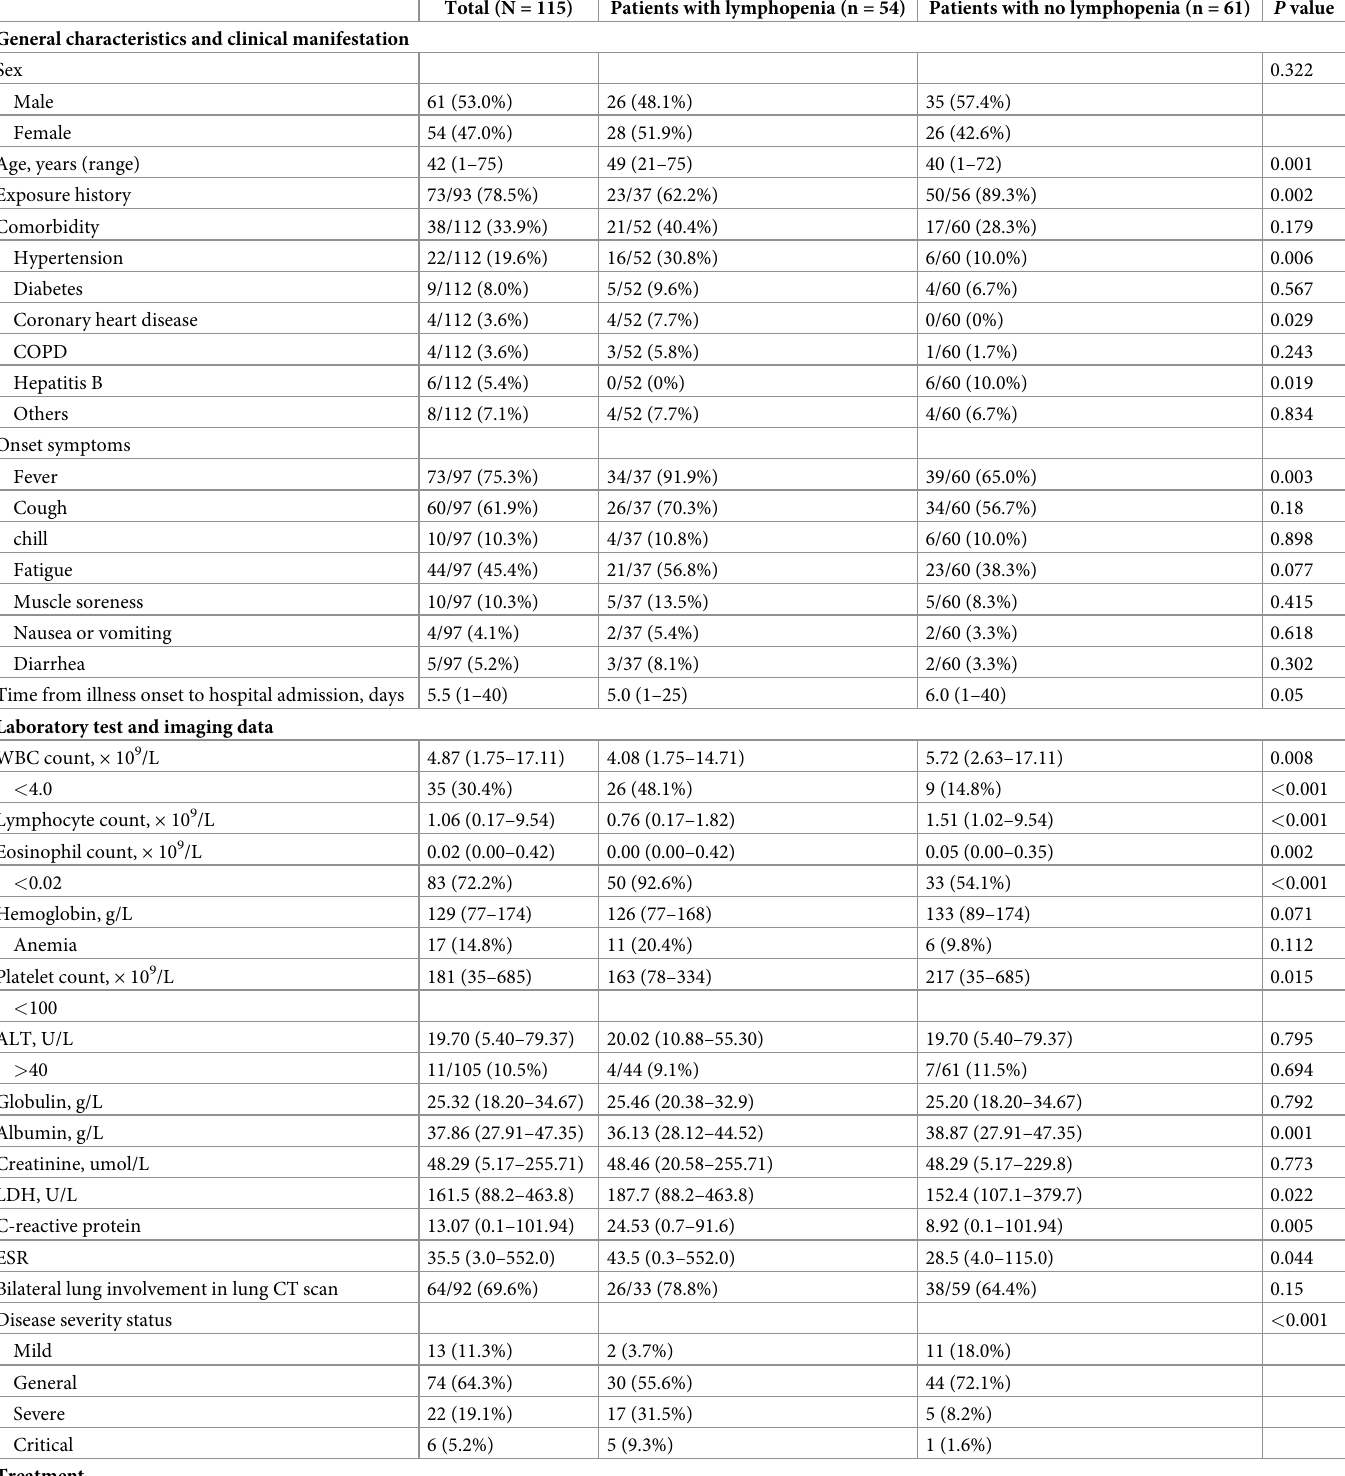
Table 1. Clinical and laboratory characteristics of patients with SARS-CoV2